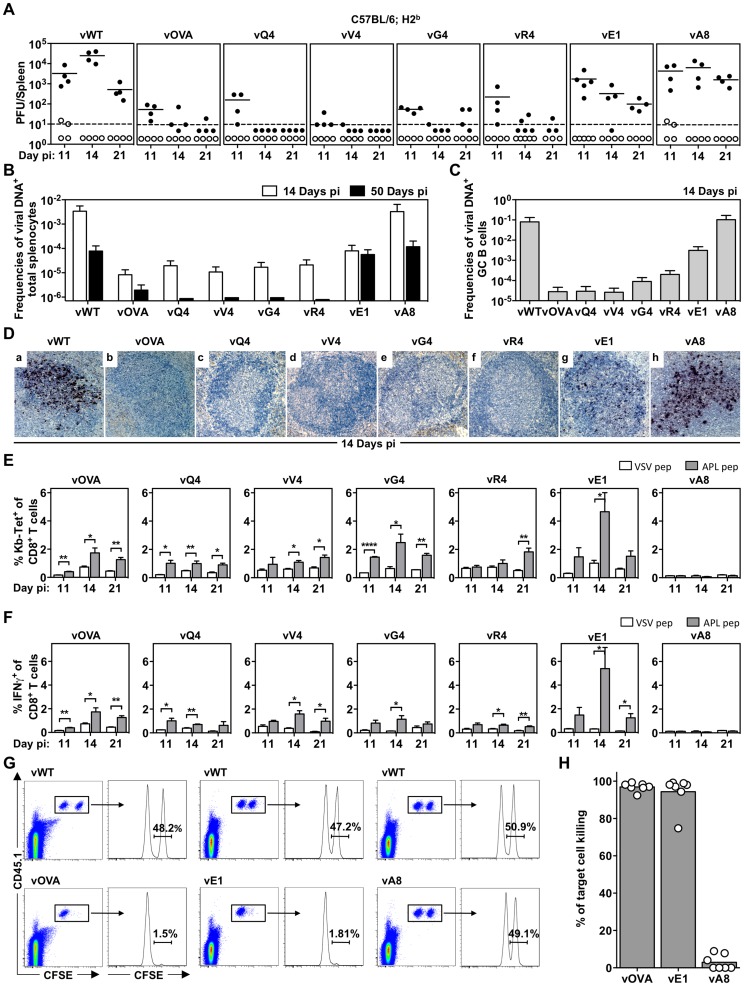
MHC class I binding by a latency-associated epitope impairs host colonization.C57BL/6 mice were infected i.n. with 104 PFU of the indicated viruses. (A) The latent load in spleens was determined by explant co-culture assay (closed symbols) and pre-formed infectious virus was quantified by plaque assay (open symbols). Each point shows the titre of 1 mouse, horizontal lines arithmetic means and dashed horizontal line limit of detection of assay. At day 14, vOVA, vQ4, vV4, vG4, vR4 and vE1 latent loads were significantly below vWT (p<0.05, by two-tailed unpaired t-test). vA8 latency loads were not significantly different from vWT (p = 0.07). (B–C) Reciprocal frequencies of viral DNA+ cells in (B) total splenocytes or (C) GC B cells. Bars represent the frequency of viral DNA+ cells with 95% confidence intervals. (D) Representative spleen sections showing dark stained latently infected cells by in situ hybridization. (E) % tetramer positive CD8+ T cells at each time point from spleens (arithmetic mean +/− SEM of 3 independent assays). * p<0.05, ** p<0.01, **** p<0.0001; using a two-tailed unpaired t-test. (F) Functional capacity of splenic CTL determined by intracellular interferon-gamma staining after ex vivo stimulation. Data show % CD8+ T cells responding to each peptide (arithmetic mean +/− SEM of 3 independent assays). * p<0.05, ** p<0.01; using a two-tailed unpaired t-test. (G–H) In vivo CTL activity at 11 days post-infection. (G) At day 10 post-infection 50∶50 mixes consisting of 2×106 unpulsed CD45.1+ CFSElo splenocytes and 2×106 OVA-, E1- or A8-pulsed CD45.1+ CFSEhi splenocytes were transferred intravenously into vOVA, vE1 or vA8 infected C57BL/6 mice. The same mix of cells was transferred into vWT infected mice C57BL/6 as internal control. In the next day, the proportion of CFSEhi and CFSElo cells among CD45.1+ cells recovered from the spleen was analysed by FACS. Representative FACS plots showing % of unpulsed CD45.1+ CFSElo and OVA-, E1, or A8-pulsed CD45.1+ CFSEhi splenocytes. (H) % target cell killing. Three to four mice were analyzed per group, and experiments repeated three times.